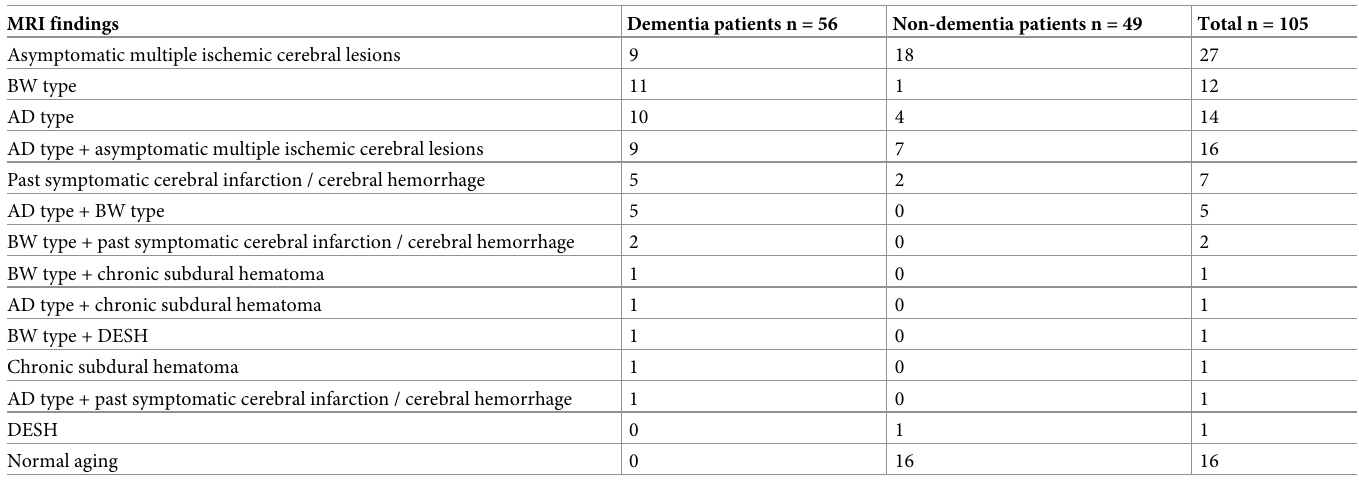
Table 2. MRI findings of 105 patients. MRI findings Dementia patients n = 56 Non-dementia patients n = 49 Total n =